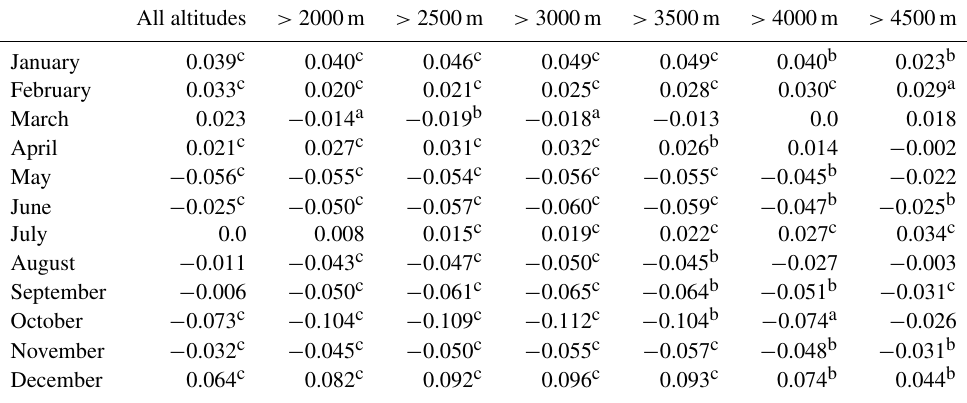
Table 5. Significance of elevation-dependent warming for monthly T min above different altitude thresholds based on the CTMD from 1979 to